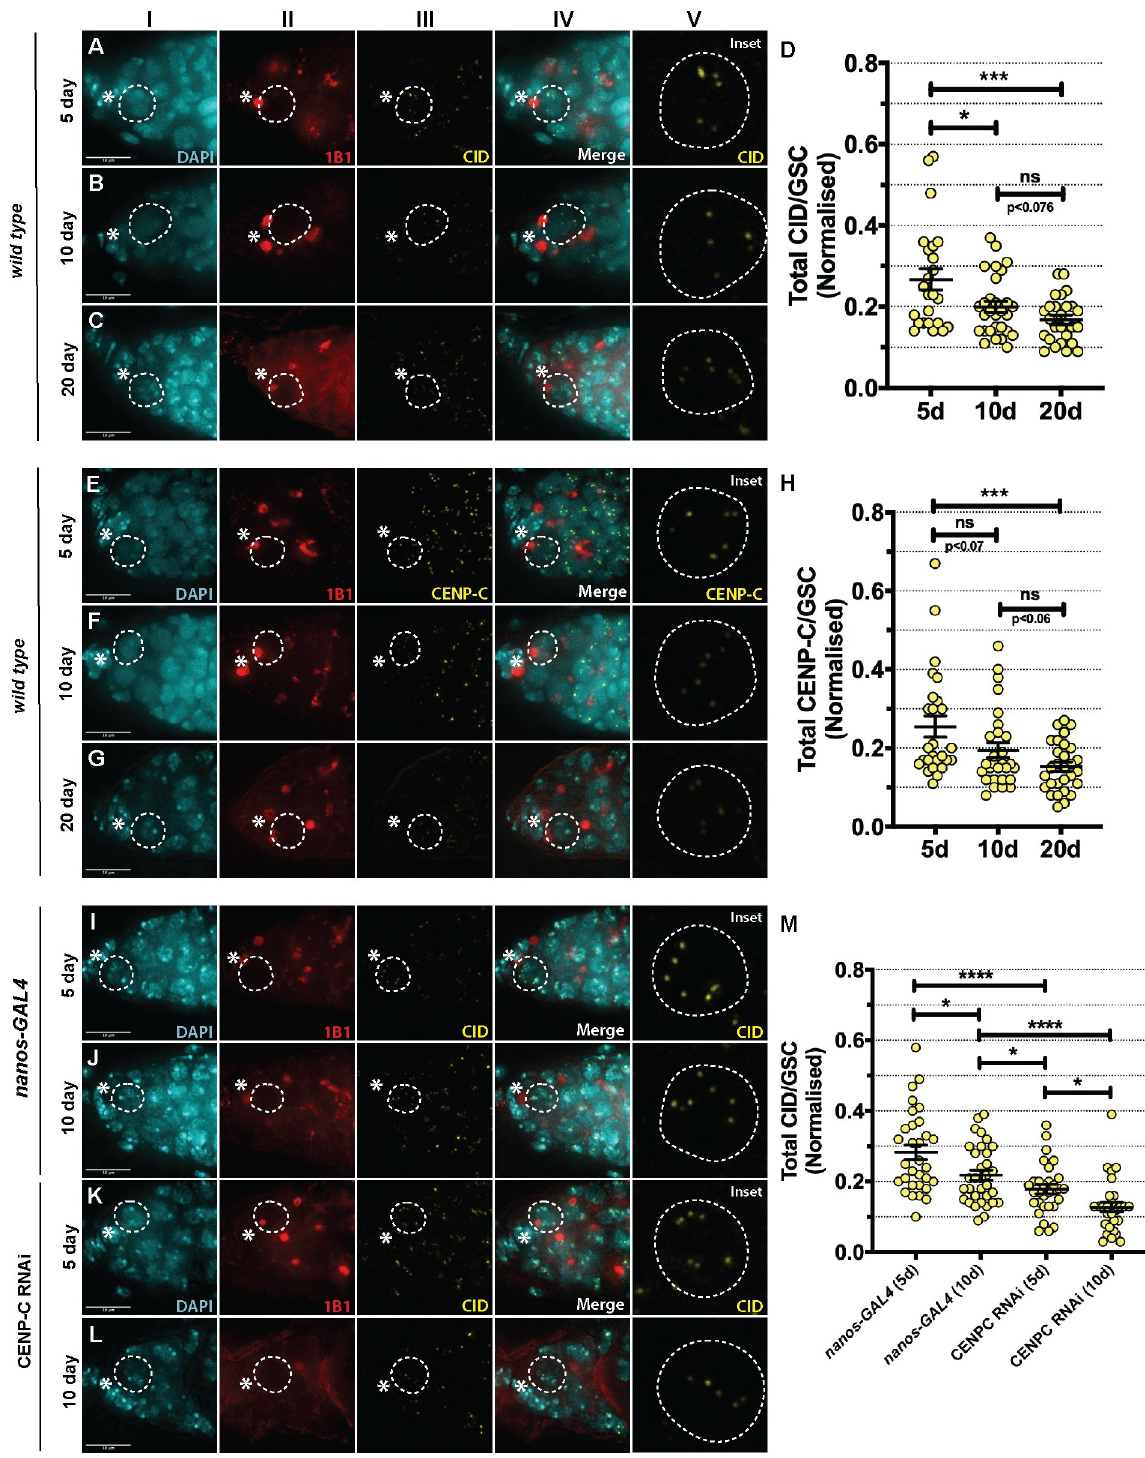
Fig 5. CID and CENP-C level is reduced in aged GSCs and CENP-C depletion accelerates CID loss. (A-C) Wild type germaria (5-, 10- and 20-day old) stained with DAPI (cyan), 1B1 (red) and CID (yellow) or (E-G) CENP-C (yellow). GSCs are boxed and inset. � denotes cap cells. Scale bar = 10 μ m. Quantitation of total CID (D) or CENP-C (H) integrated density in wild type GSCs at 5-, 10- and 20-days post eclosion. � p < 0.05, ��� p < 0.001, ns = non-significant. Error bars = SEM. (I-L) Germaria of nanos-GAL4 (5d, 10d) and CENP-C RNAi (5d, 10d differentiation defect phenotype) stained with DAPI (cyan), 1B1 (red) and CID (yellow). GSCs are boxed and inset. � denotes cap cells. Scale